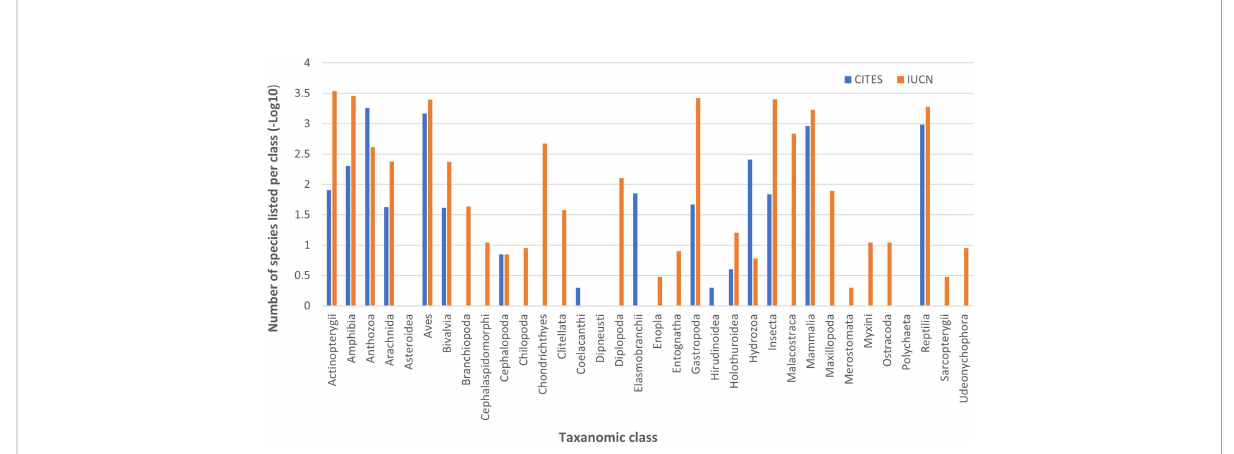
FIGURE 2 Number of species [log transformed] listed per taxonomic class, on the IUCN Red List and the CITES